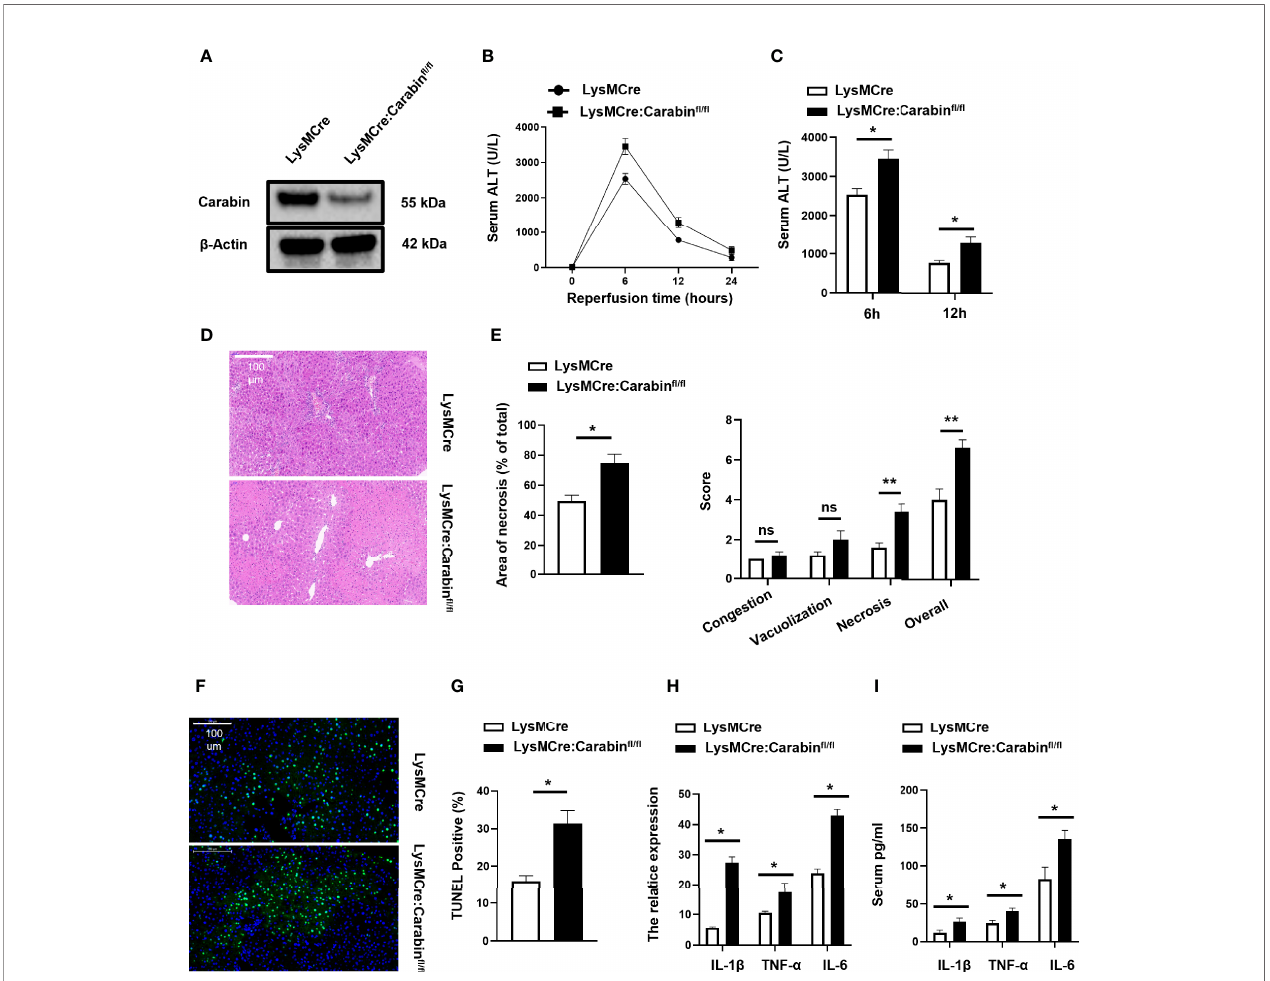
FIGURE 1 | Carabin de fi ciency aggravates liver damage following hepatic I/R. (A) CD11b + cells from Carabin fl / fl , LysMCre and LysMCre: Carabin fl / fl transgenic mice were isolated by fl ow cytometry, and Western-blot analysis for Carabin was performed. (B) Serum ALT levels in LysMCre and LysMCre: Carabin fl / fl mice were detected at 0, 6, 12, and 24 h after reperfusion. Data are presented as the mean ± SEM (n = 5 mice/group). (C) Analysis of serum ALT levels in LysMCre and LysMCre : Carabin fl / fl mice subjected to reperfusion for 6 and 12 h. (D) H&E staining of liver tissue in each treatment group was performed to evaluate hepatic damage. Scale bar, 100 µm. (E) Statistical analyses of the area of necrosis. Data are presented as mean ± SEM (n = 5 mice/group, 3-5 fi elds were quanti fi ed). (F) Hepatic apoptosis was detected by TUNEL assays. Scale bar, 100 µm. (G) Statistical analyses of the number of TUNEL-positive cells. Data are presented as the mean ± SEM (n = 5 mice/group, 3-5 fi elds were quanti fi ed). (H) Expression levels of IL-1 b , TNF- a , and IL-6 were measured by qRT-PCR. Data are presented as mean ± SEM (n = 5 mice/group). (I) Serum IL-1 b , TNF- a , and IL-6 levels were measured by ELISAs. Data are presented as mean ± SEM (n = 5 mice/group). *P < 0.05; **P < 0.01. ns, no signi fi